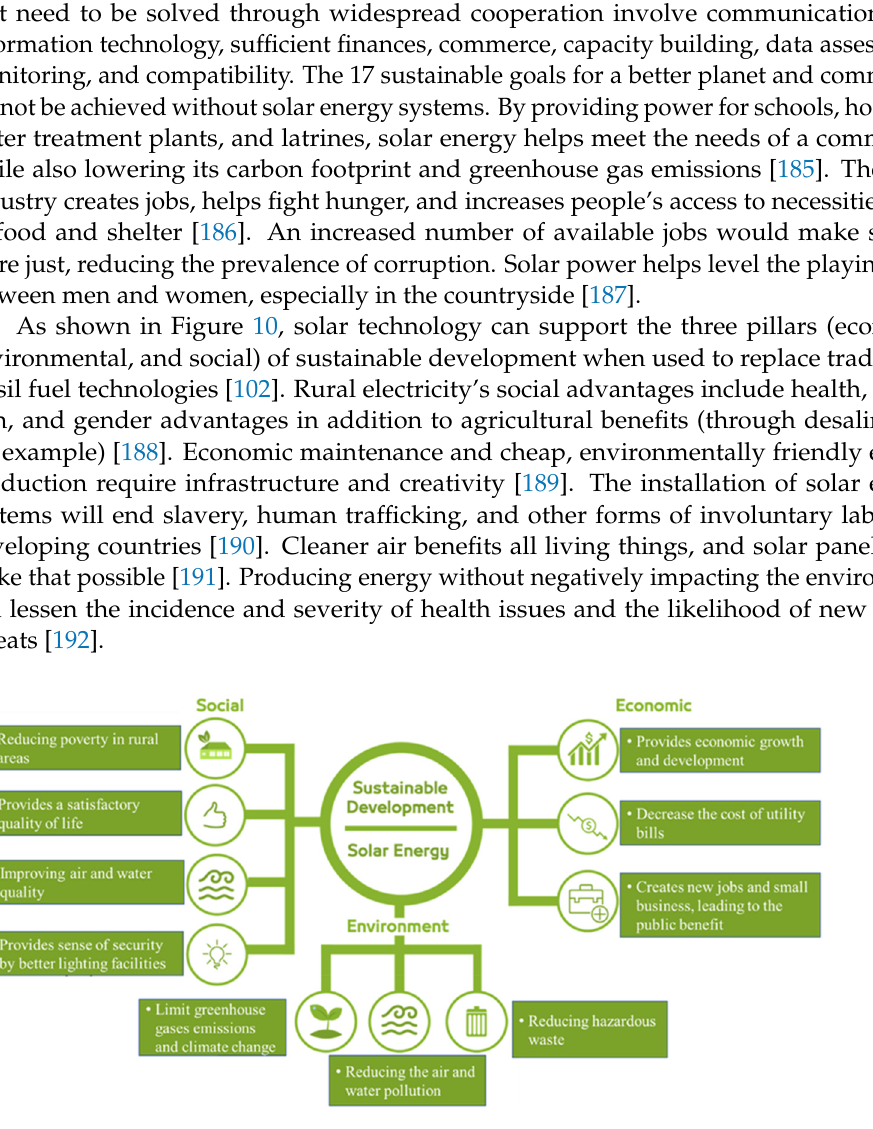
Figure 10. Contribution of solar energy to the three pillars of sustainable development [102], open access.